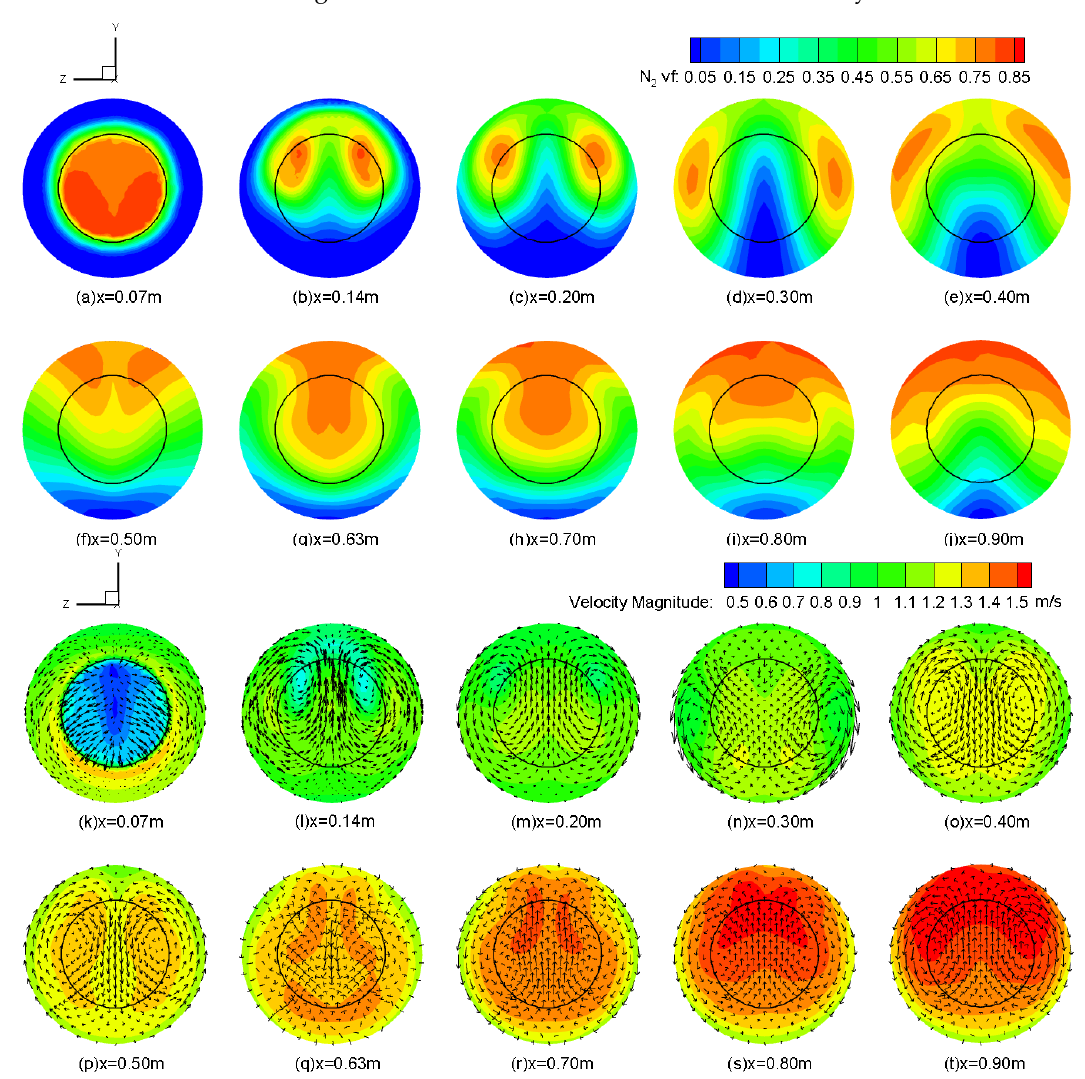
Figure 4. The distributions of the nitrogen volume fraction and velocity of ten cross sections at X ‐ positions (Case 1 ‐ 1). X-positions (Case